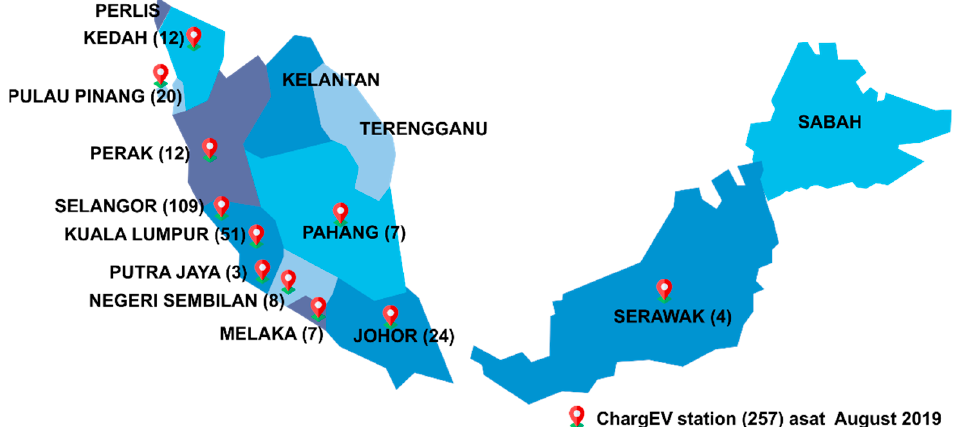
Figure 3. Distribution of public AC charging stations by the charge network across Malaysia [29]. Courtesy of Malaysian Green Technology and Climate Change Centre.